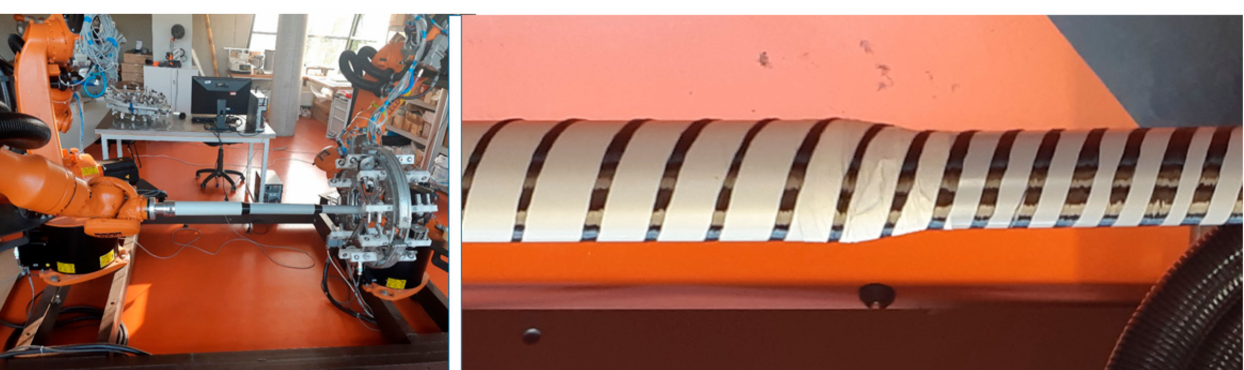
and frame parts with different cross-sectional radii r 1 = 30 [mm], 6